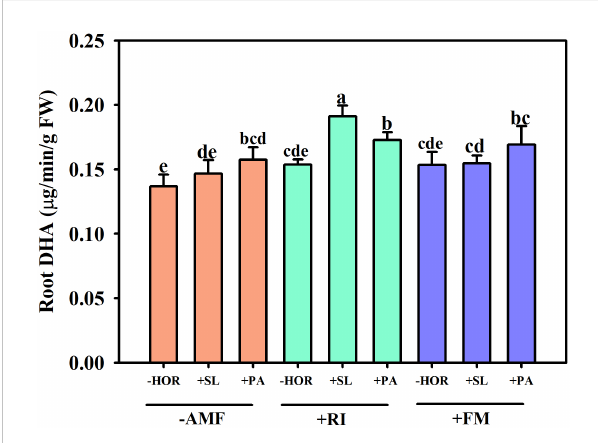
FIGURE 4 AMFs and plant hormones interaction signi fi cantly increased the root DHA activity. Different lowercase letters in a fi gure indicate that the mean values are signi fi cantly different (P < 0.05) from each other according to LSD test. The same